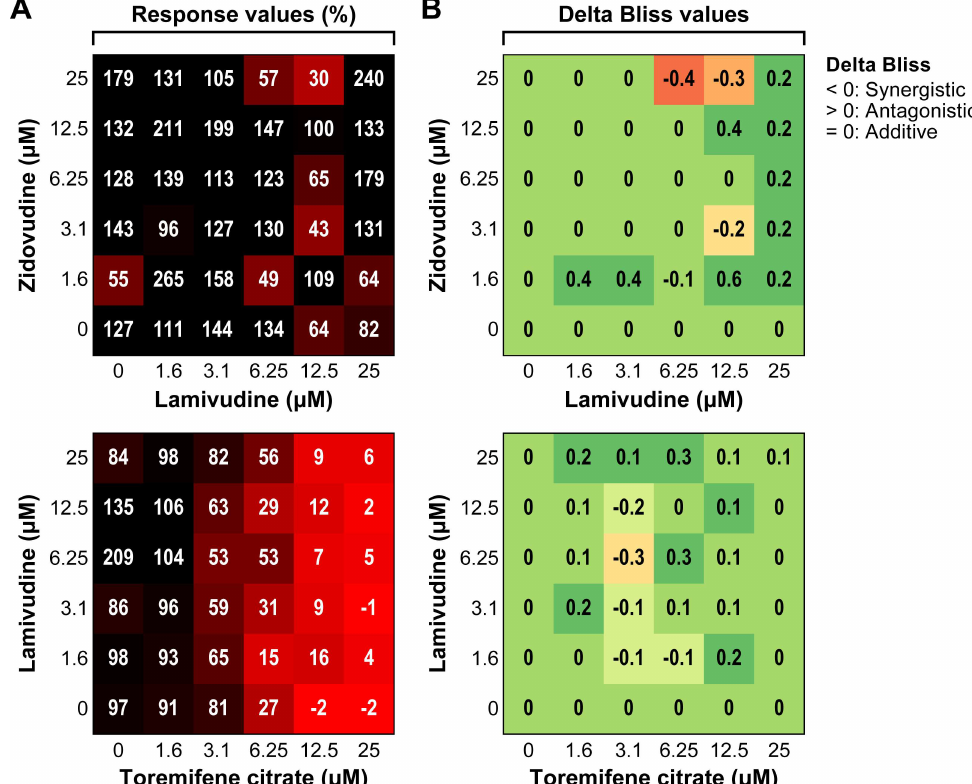
females, 16837 h (cid:1) ng/ml versus 12584 h (cid:1) ng/ml. The elimination half-life (t